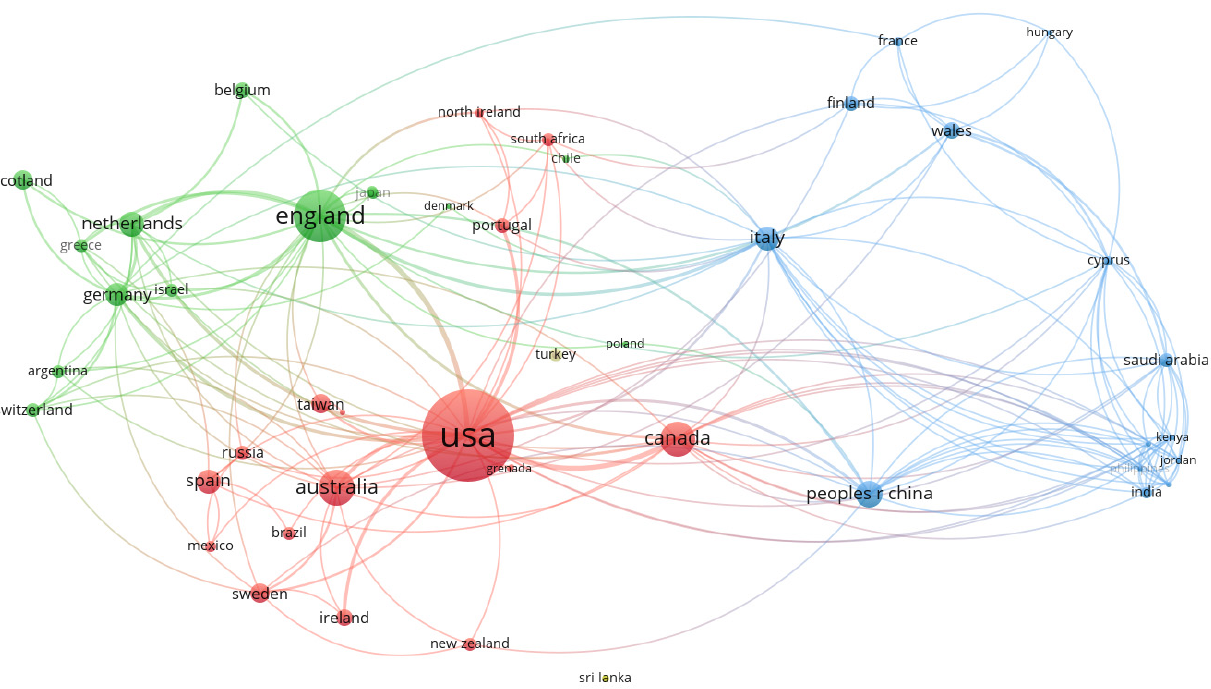
Figure 3. Country collaboration